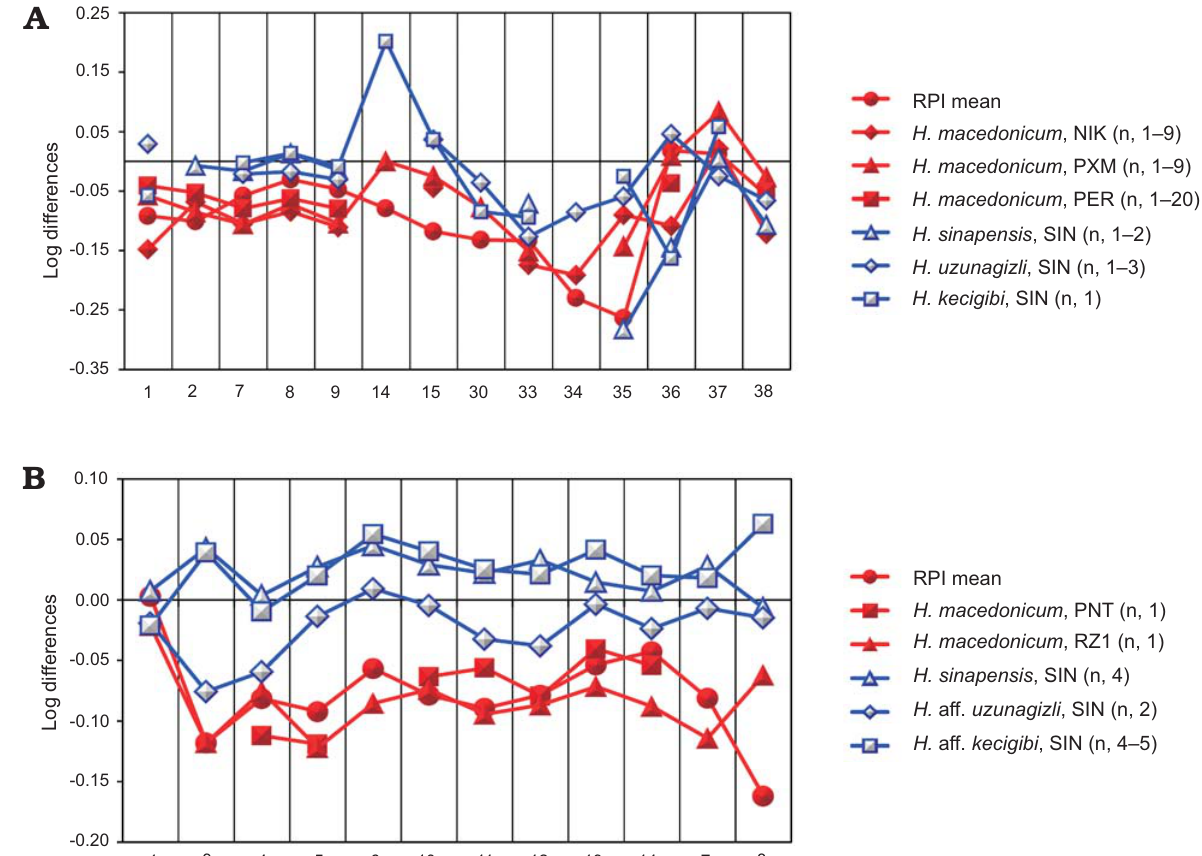
Fig. 8. Logarithmic ratio diagram comparing the RPl skull ( A ) and third metatarsal ( B ) with the Vallesian hipparions from Sinap, Turkey. Hipparion med- iterraneum from Pikermi (Koufos 1987a) is used as standard of comparison. The metrical data for the Sinap material were provided to me by Raymond L. Bernor (unpublished material, personal communication,